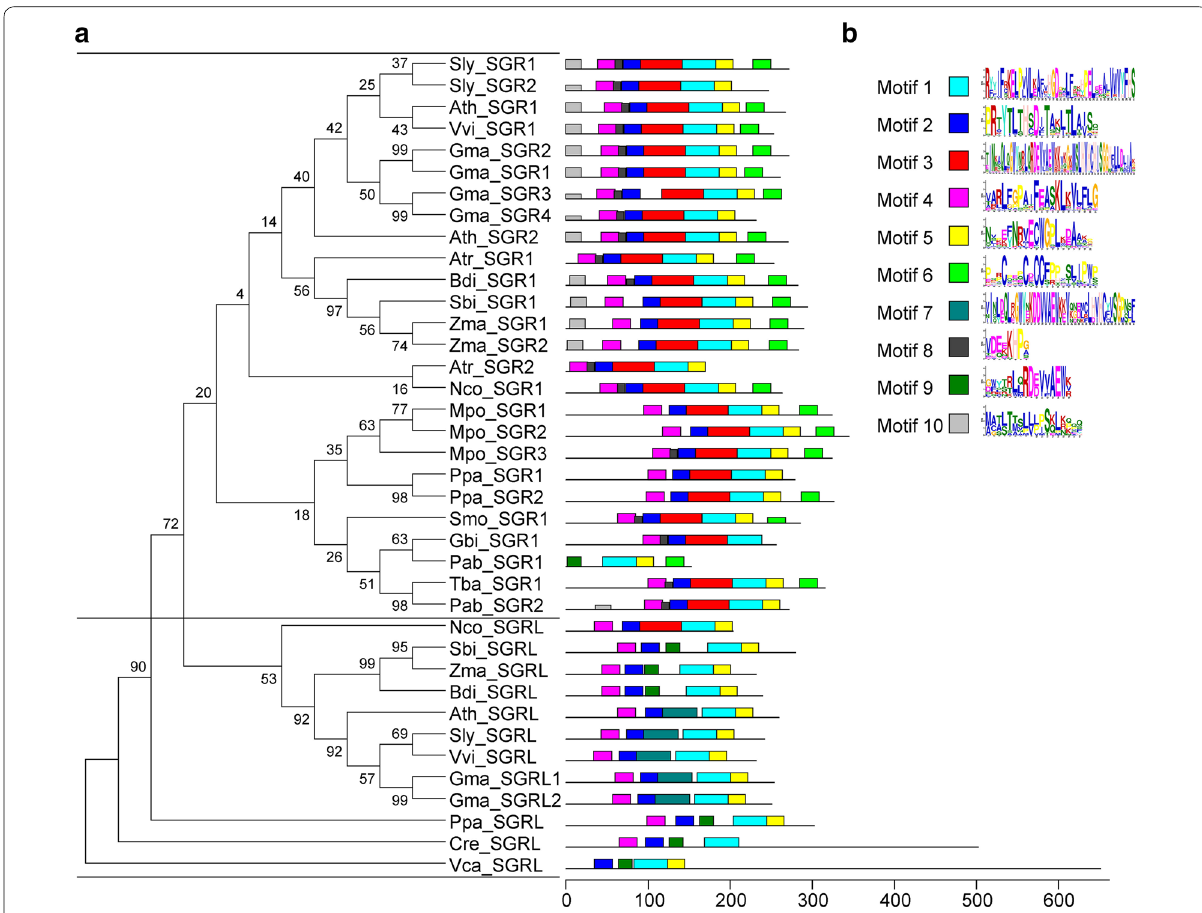
Fig. 1 Phylogenetic tree and protein structure of SGR proteins. a Phylogenetic analysis of SGR proteins from various species. The phylogenetic tree of all sequences was constructed using Phylip 3.69 (http://evolu tion.gs.washi ngton .edu/phyli p.html) by the Neighbor-Joining (NJ) method, and with a bootstrap test with 1000 replications (Ming et al. 2020). The information of the SGR proteins is in Additional file 1: Table S1. b Conserved motifs of the SGR proteins were obtained using the MEME software (Zhang et al. 2018)